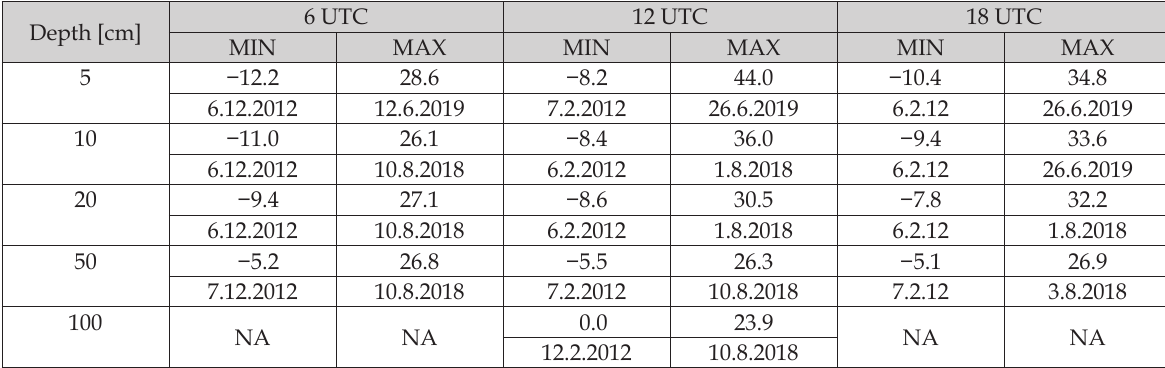
100 NA NA 11.0 NA NA – not available. Table 10. Values of absolute ground temperature extremes [°C] at various depths and dates of their occurrence in Poznań in